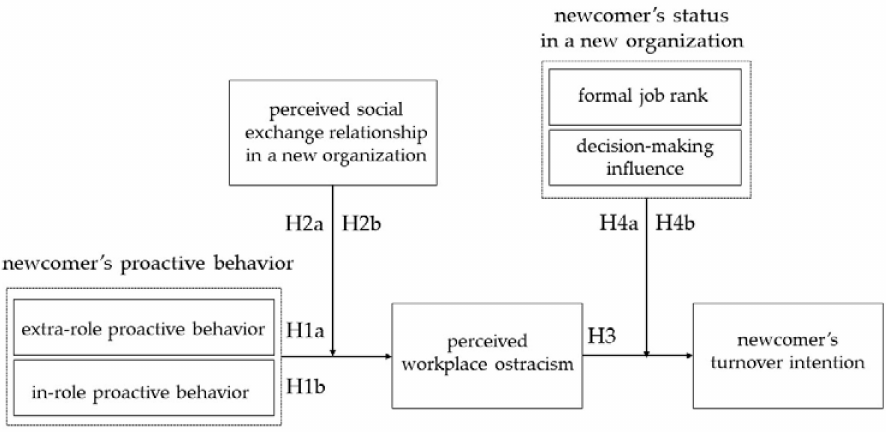
Figure 1. Hypothesized